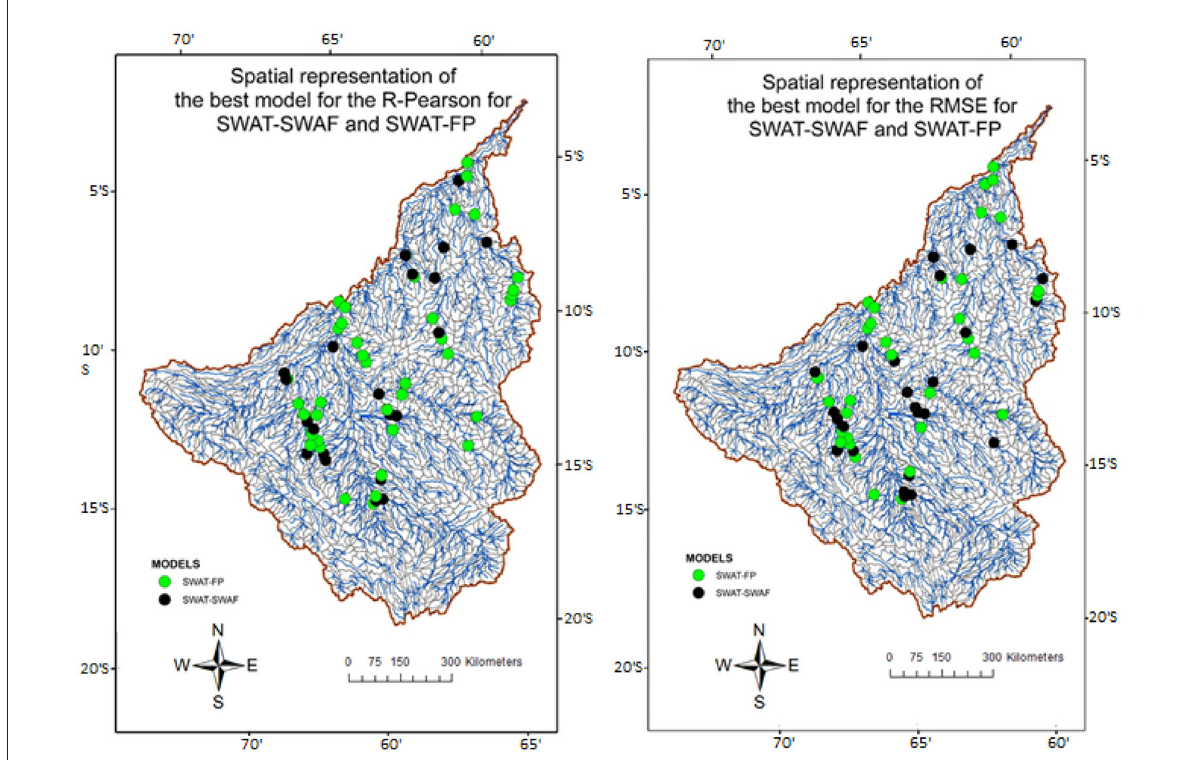
FIGURE9 Spatial representation of the best framework on each validation point for the R-Pearson index (left) and the RMSE index (right) . Green dots mean that the index is better for SWAT-FP while black dots correspond to SWAT-SWAF. Both models appear close in term of